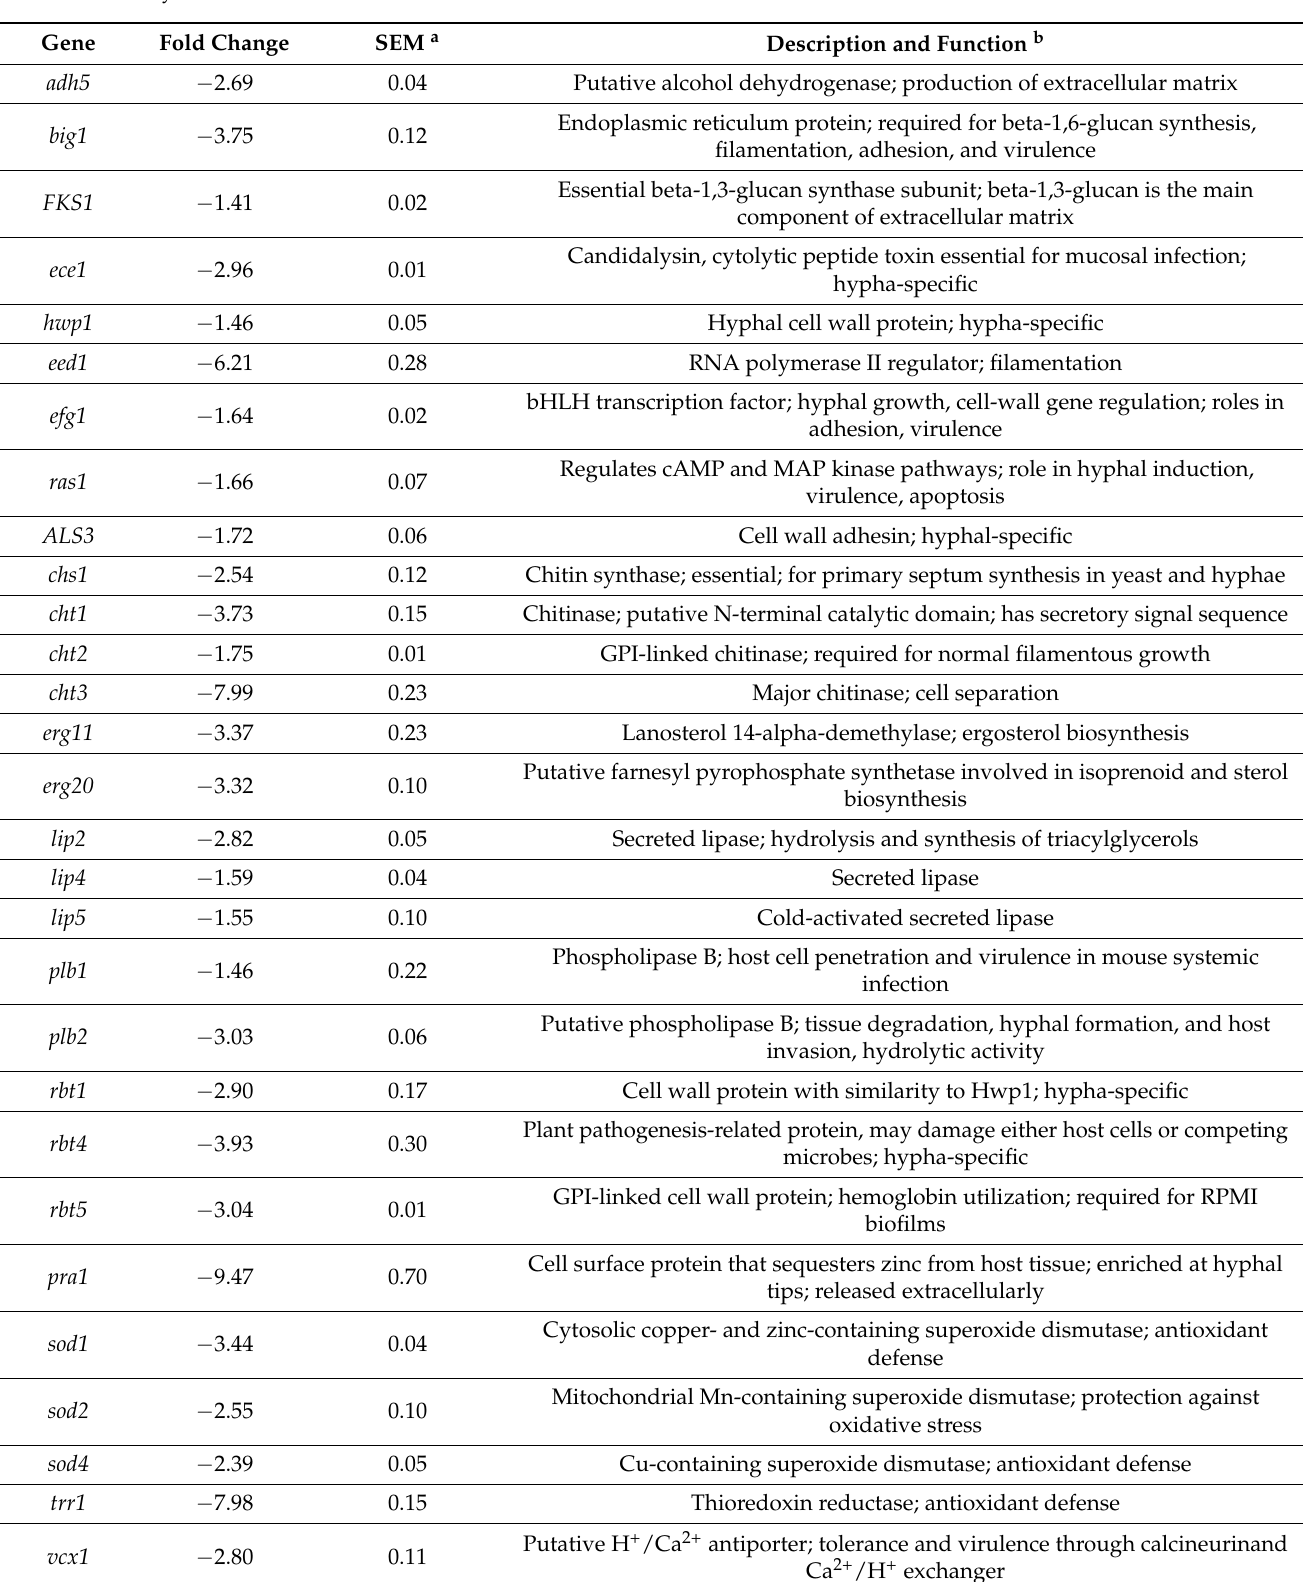
Table 1. Genes downregulated in CBD-treated C. albicans biofilm compared to their expression in untreated control as identified by real-time